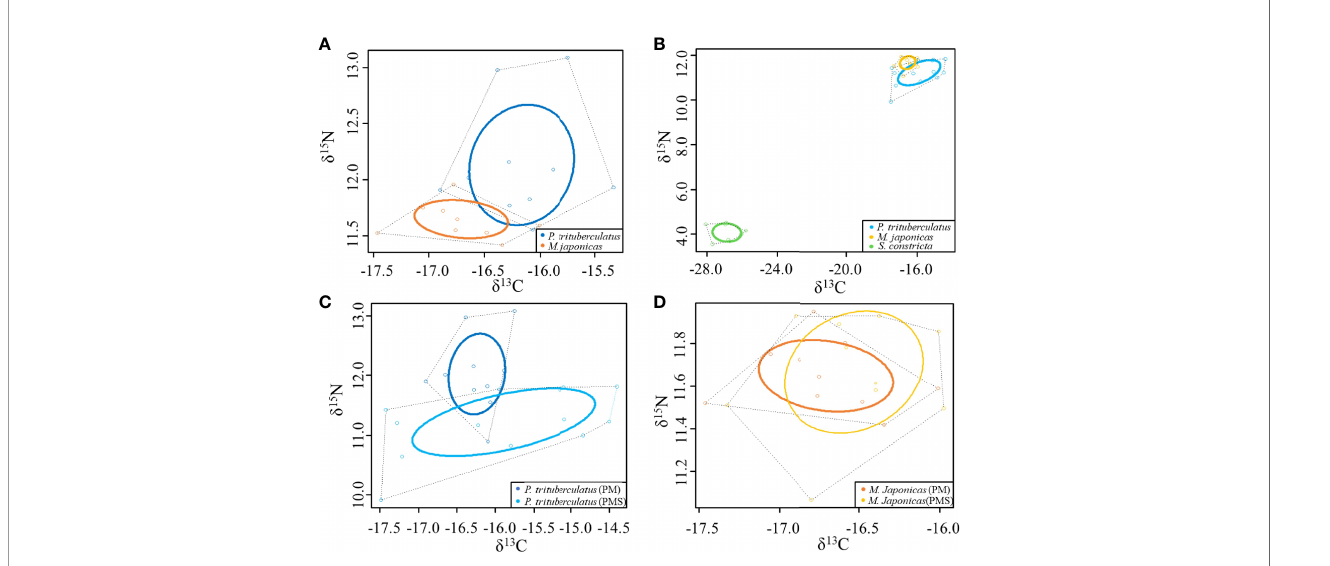
FIGURE 5 | Stable isotopic niches of cultured organisms. (A) Stable isotopic niches of cultured organisms in the PM system; (B) Stable isotopic niches of cultured organisms in the PMS system; (C) Stable isotopic niches of P. trituberculatus in the PM and PMS systems; (D) Stable isotopic niches of M. japonicus in the PM and PMS